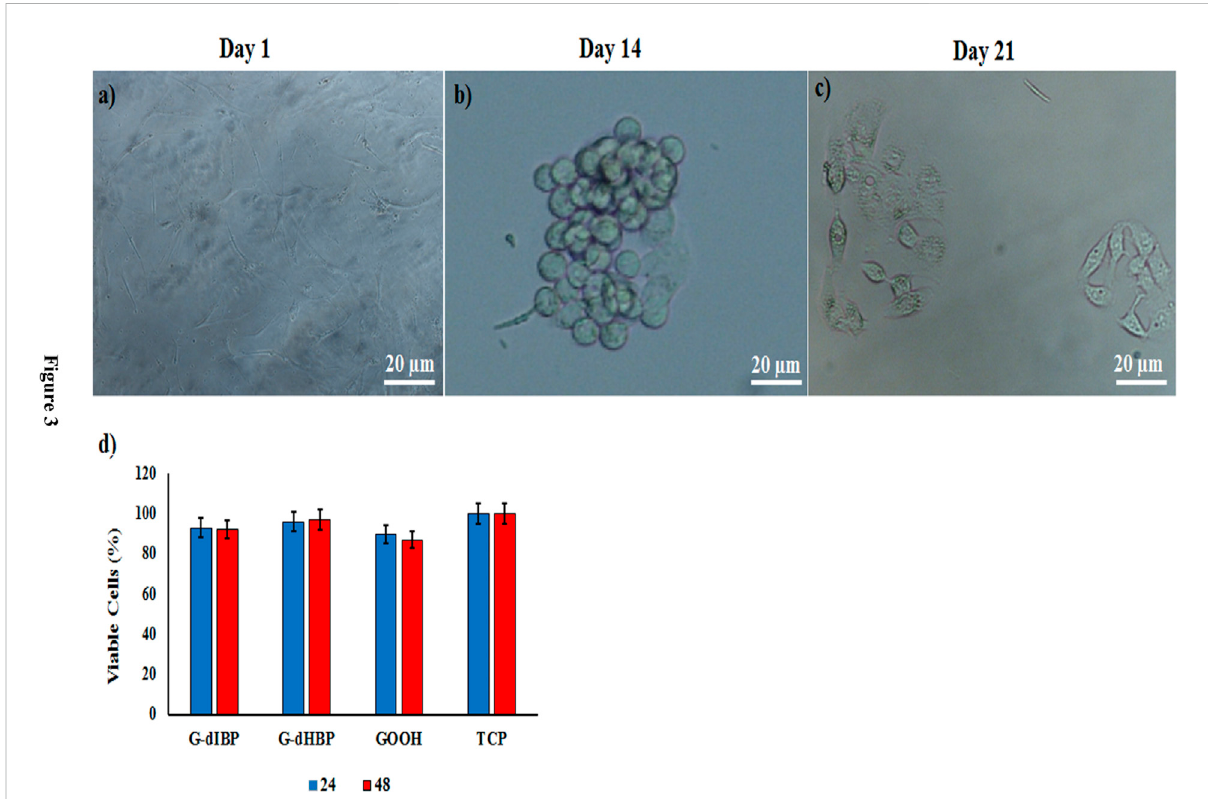
FIGURE 3 Time-dependent kinetics of MSCs differentiation to HLCs (A,B,C) . (D) Viability of cultured cells on different platforms. TCP indicates Tissue Culture Plate as